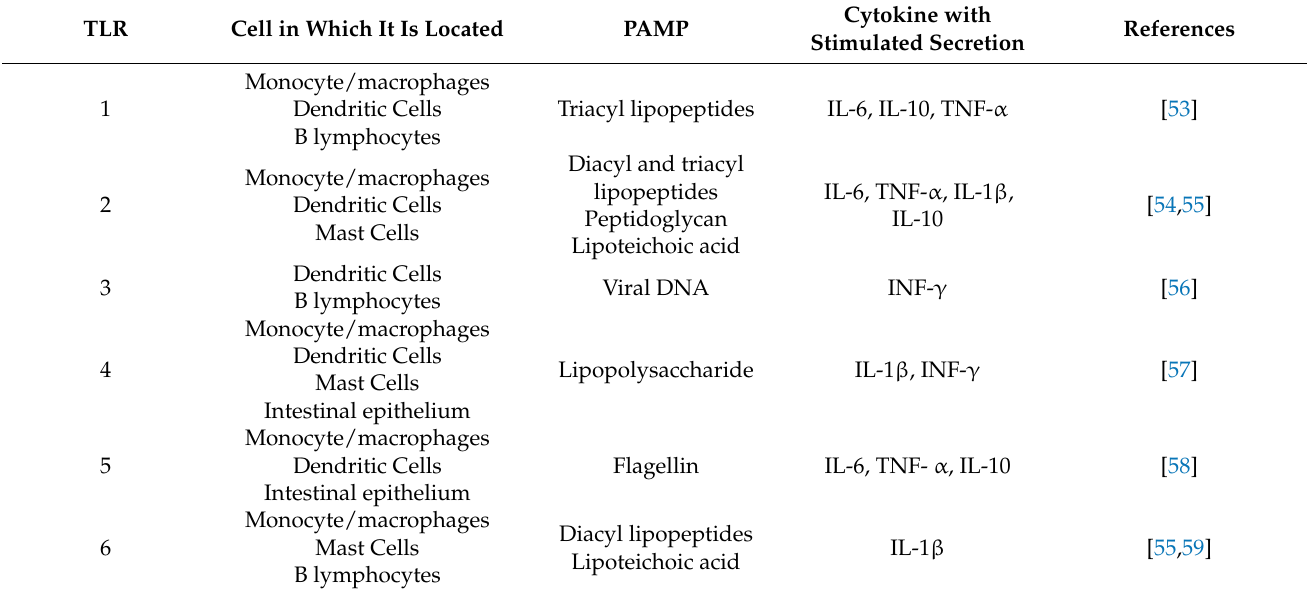
Table 1. Cells with TLRs, their ligands, and the cytokines they stimulate to be secreted. TLR Cell in Which It Is